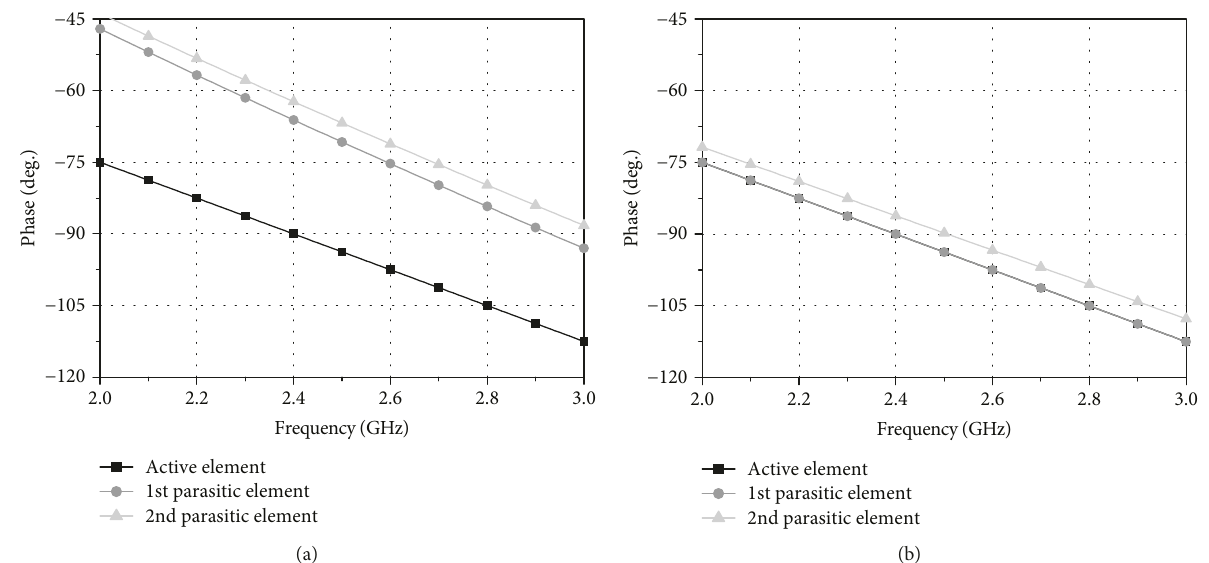
Figure 3: E ff ective electric lengths for parasitic elements relative to the λ /2 active element with a reactive load of (a) 1.5pF for a director and (b) 0.1 μ F for a re fl